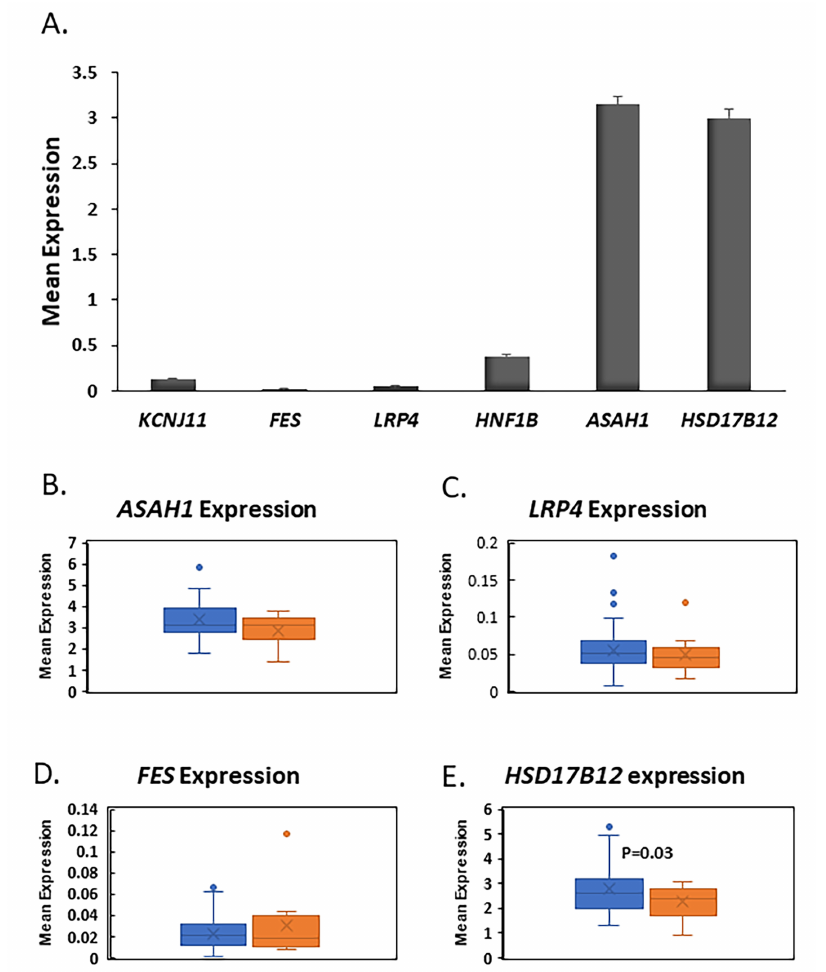
Figure 4. Gene expression in human pancreatic islets. ( A ) RNA-seq mean expression of FES , LRP4 , ASAH1, and HSD17B12 in non-diabetic human pancreatic islets ( n = 63). KCNJ11 gene was used as functional marker for pancreatic islets; ( B – E ) Whisker boxes of di ff erential expression analysis of ASAH1, ( B ) LRP4, ( C ) FEX , and ( D ) HSD17B12 ; ( E ) in pancreatic islets of diabetics ( n = 12) and non-diabetics ( n = 63). HSD17B12 was significantly downregulated in T2D islets ( p =